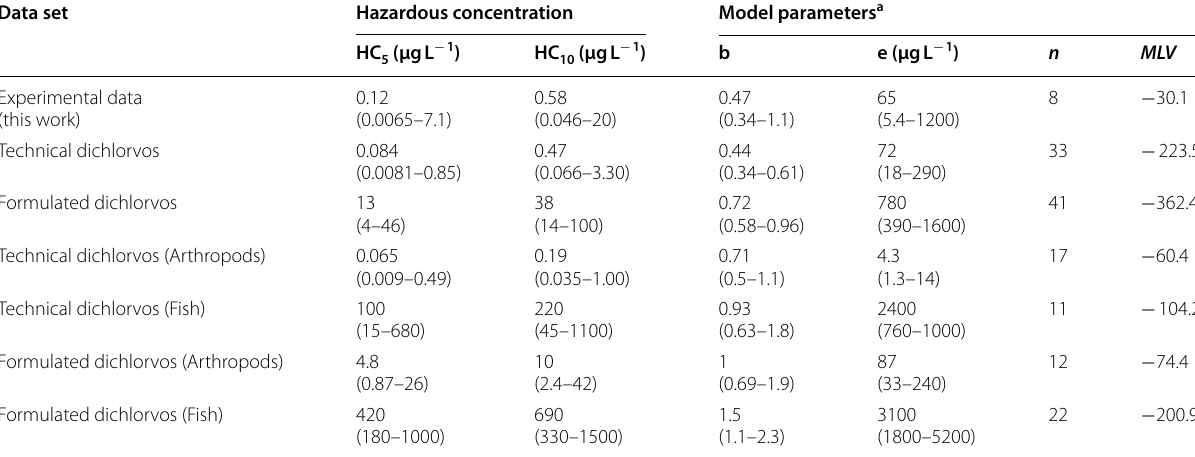
a Values are given with 95% confidence interval, MLV maximum likelihood values